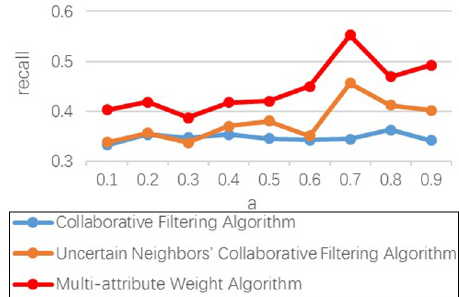
Figure 1. Curve of three algorithms ’